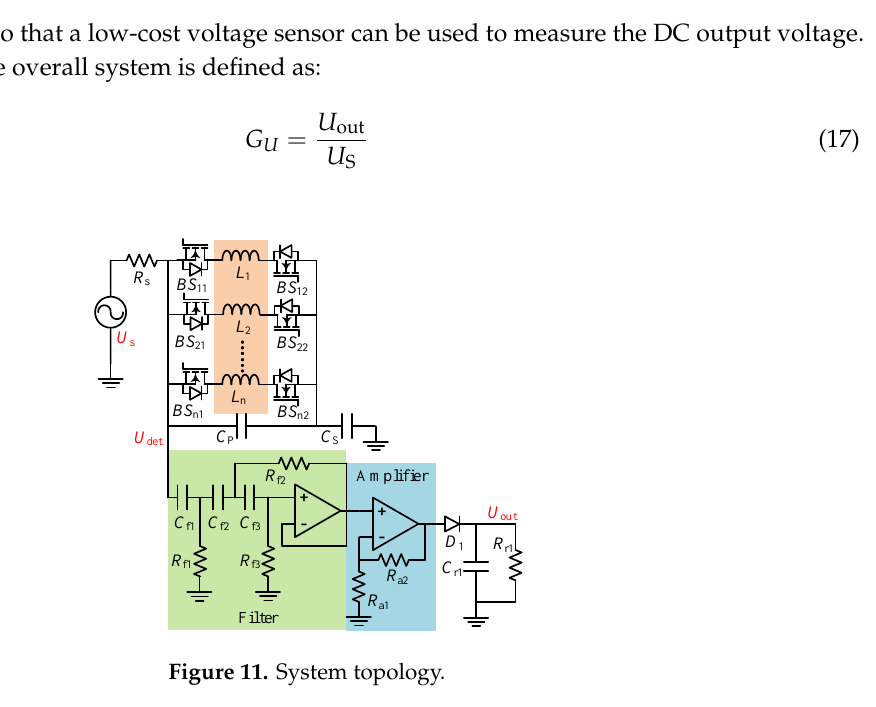
Figure 10. The input impedance of the resonant circuit and δ change with the operating frequency f .